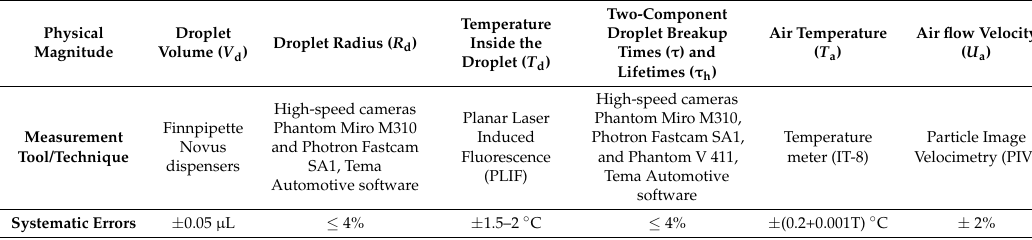
Table 4. Main registered parameters and